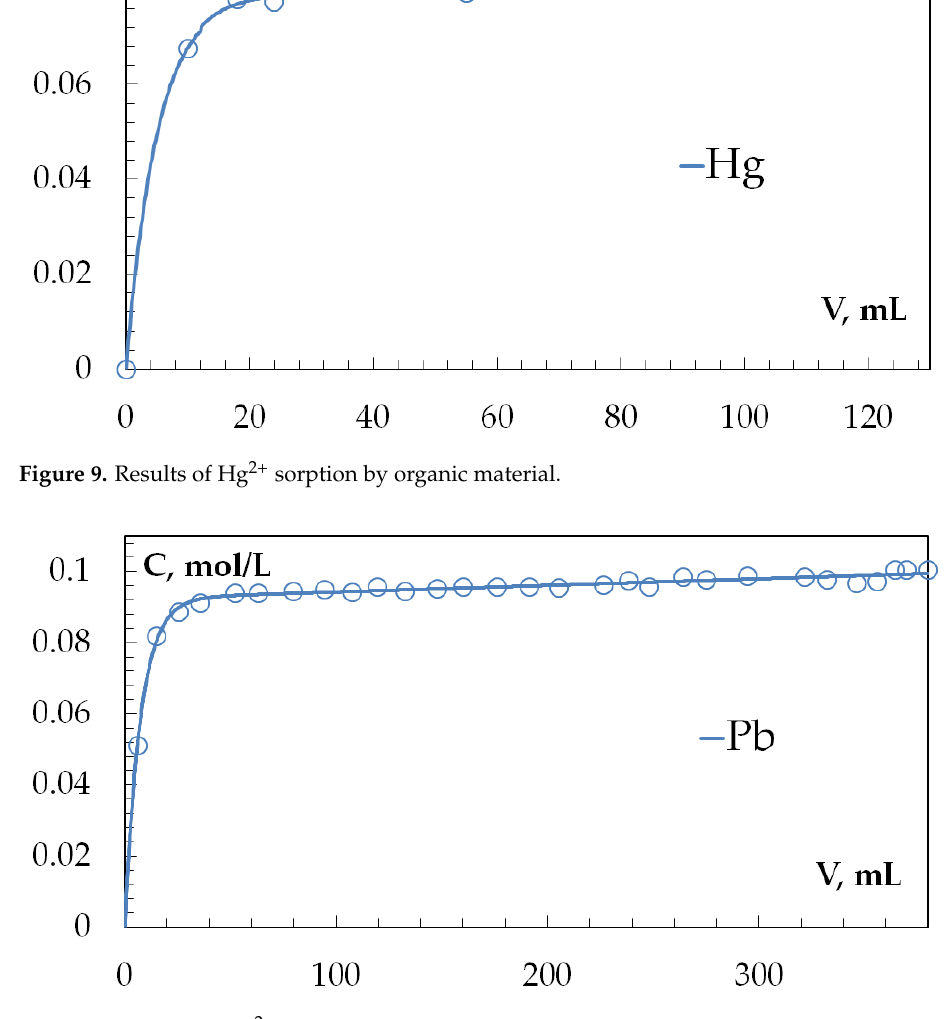
Figure 10. Results of Pb 2+ sorption by organic material.